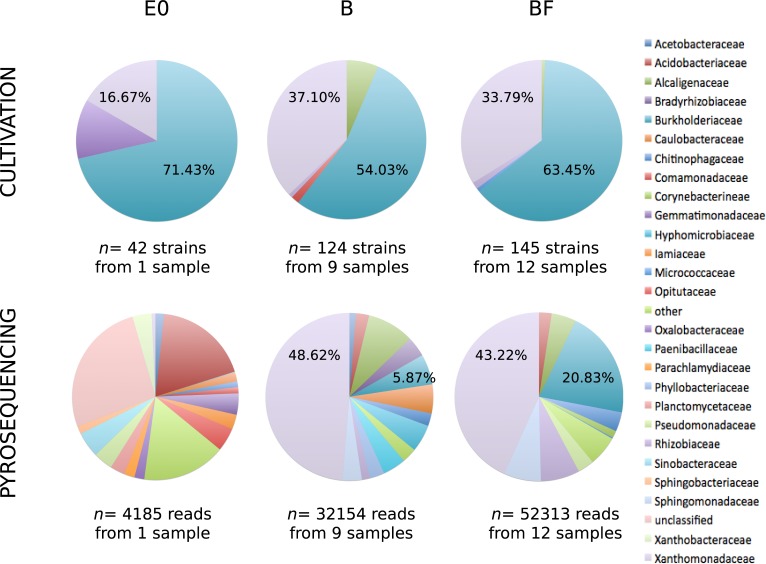
Pie charts comparing the taxonomic diversity of the bacterial OTUs from E0, B and BF samples at the family level, using culture-dependent and culture-independent (pyrosequencing) approaches [25].Families that accounted for less than 1% in a sample are summarized in a category termed “other”.